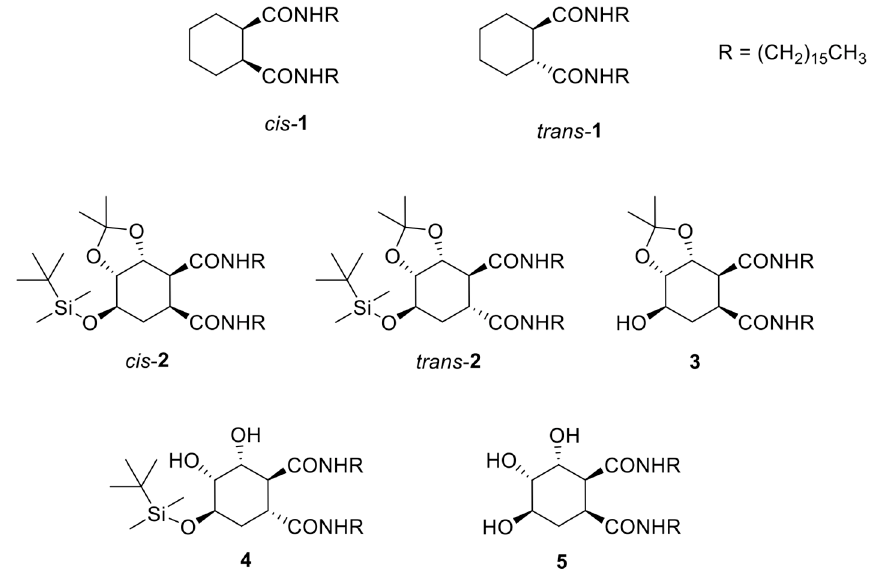
Figure 1. Previously studied LMWOGs ( cis - and trans - 1 ) [16] and new LMWOGs investigated in this work ( 2 – 5 ).